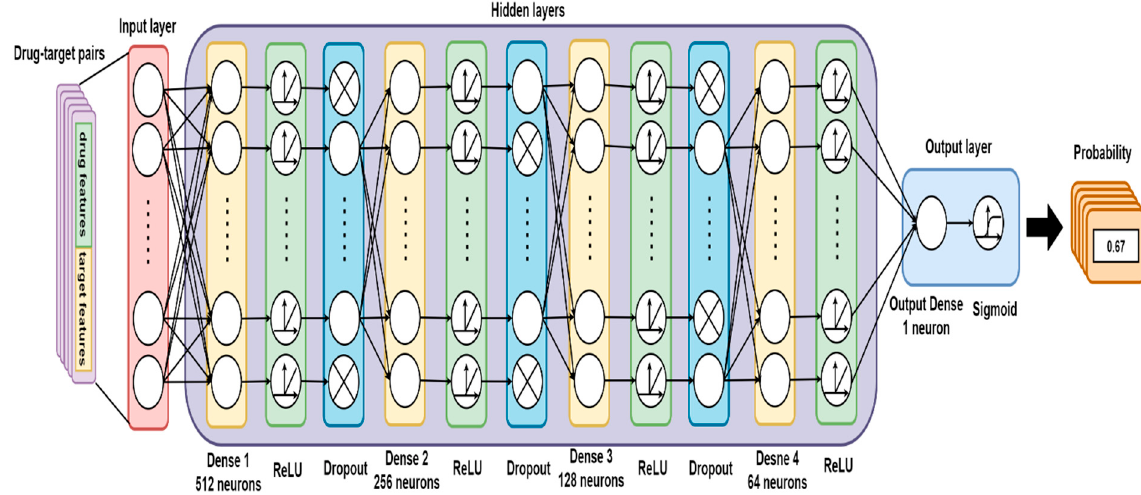
Figure 4. The schematic diagram of the DNN-based DTI model.